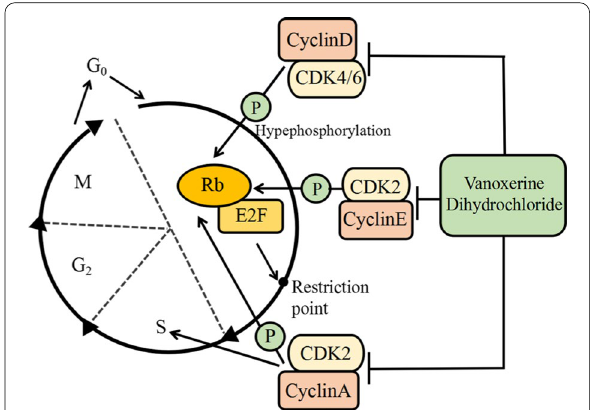
Fig. 5 Mechanisms of vanoxerine dihydrochloride. Vanoxerine dihydrochloride inhibited CDK4/6 phosphorylation and the complex with cyclinD. It also inhibited CDK2 phosphorylation and the complex with cyclinE. Together, they suppress the hyperphosphorylation of RB, and the releases of pRB from its association with transcription factor E2F. As a result, it inhibits the cell cycle to proceed from G1 to S‑phase. In addition, vanoxerine dihydrochloride also reduced cyclinA‑CDK2 complex, and inhibited DNA replication and decrease S and G2‑M phases The predicted conformations of vanoxerinedihydrochloride and CDK2/4/6 The predicted two-dimensional chemical structure of vanoxerinedihydrochloride is shown in Fig. 6a. Based on the results from computer docking, we predicted that vanoxerinedihydrochloride interacts with CDK2 and resides in the ATP-binding site of CDK2 with hydropho- bic binding with ILE10, LYS33, VAL64, PHE80, ALA144, and a salt bridge with ASP145, and a halogen bond with GLU81 (Fig. 6b). It interacts with CDK4 ATP-binding site through two salt bridges with ASP104, a π interaction with LYS40, and a halogen bond with PHE98 (Fig. 6c), and interacts with CDK6 ATP binding site through a hydrogen bond with ILE19, a salt bridge with ASP104 and a π interaction with PHE98 (Fig. 6d). Results from western blotting indicated that vanoxerine dihydrochlo- ride inhibited the activities of CDK2/4/6 with similar effi- cacy, suggesting that it has comparable binding affinity to all three CDKs.